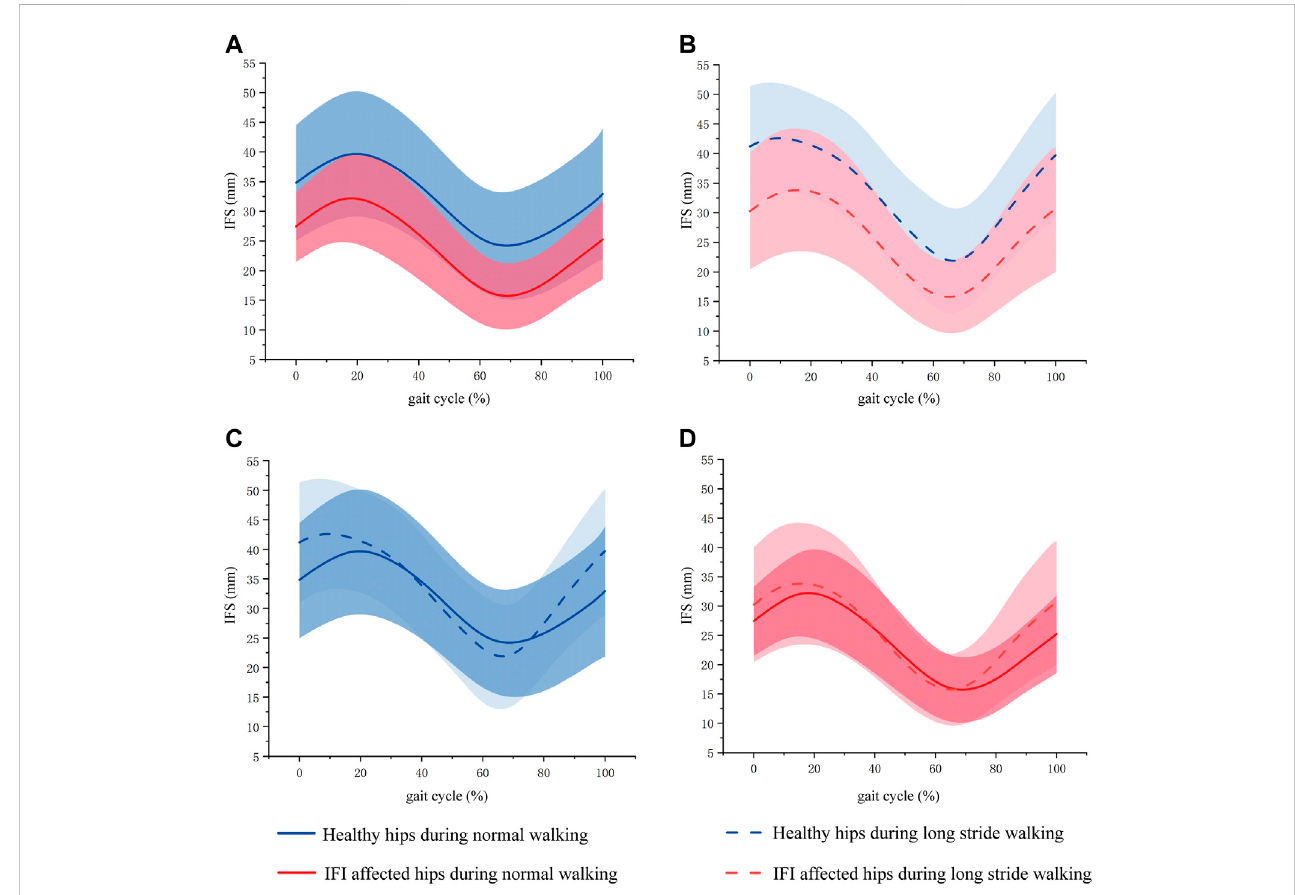
FIGURE 4 Mean(line)andstandarddeviation(shadedarea)ofIFSduringgaitphaseofnormalandlongstridewalking. (A) WastheIFSofhealthyhipsandIFIaffectedhips duringnormalwalking. (B) WastheIFSofhealthyhipsandIFIaffectedhipsduringlongstridewalking. (C) WastheIFSofhealthyhipsduringnormalandlongstride walking. (D) WastheIFS ofIFI affectedhipsduring normalandlongstridewalking. The bluecurveisthemeanandstandarddeviationofIFSinhealthyhips, where thesolidbluelineistheIFSduringnormalwalking,andthedashedlineistheIFSduringlongstridewalking.Theredcurveisthemeanandstandarddeviation of IFS in IFI affected hips, where the solid blue line is the IFS during normal walking, and the dashed line is the IFS during long stride